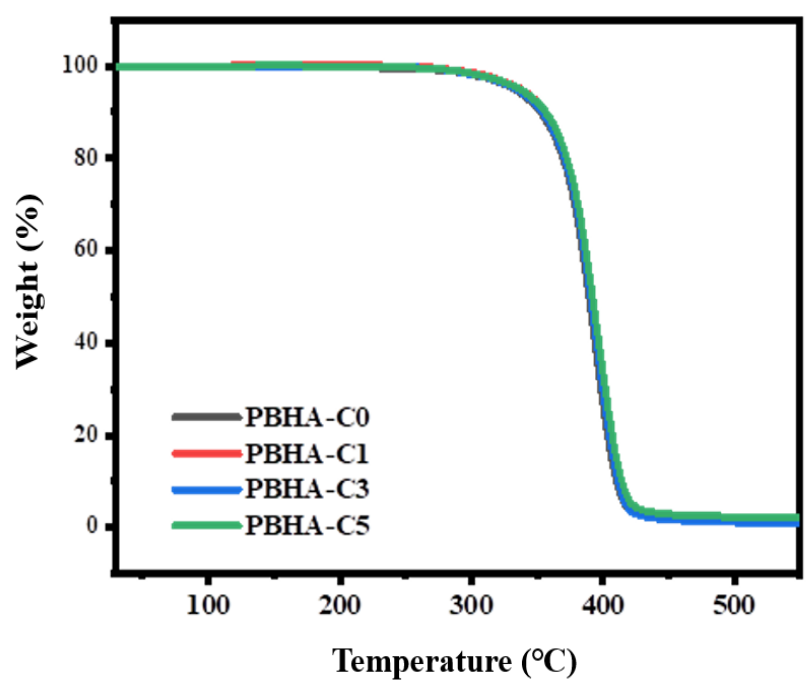
Figure 4. Weight loss as a function of temperature for PBHA-Cn copolymers.